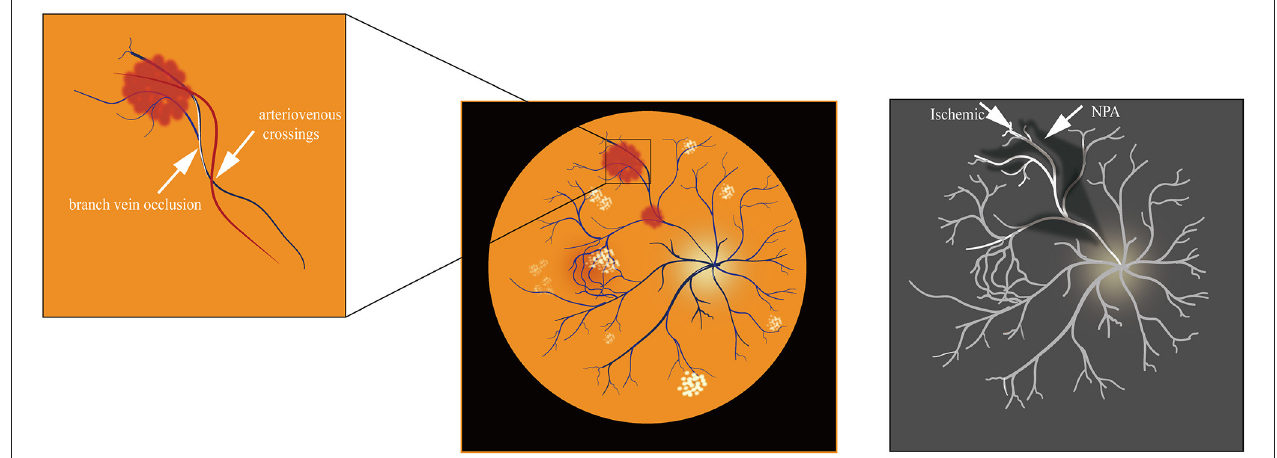
FIGURE 2 | Fundus photograph and OCTA of ischemic